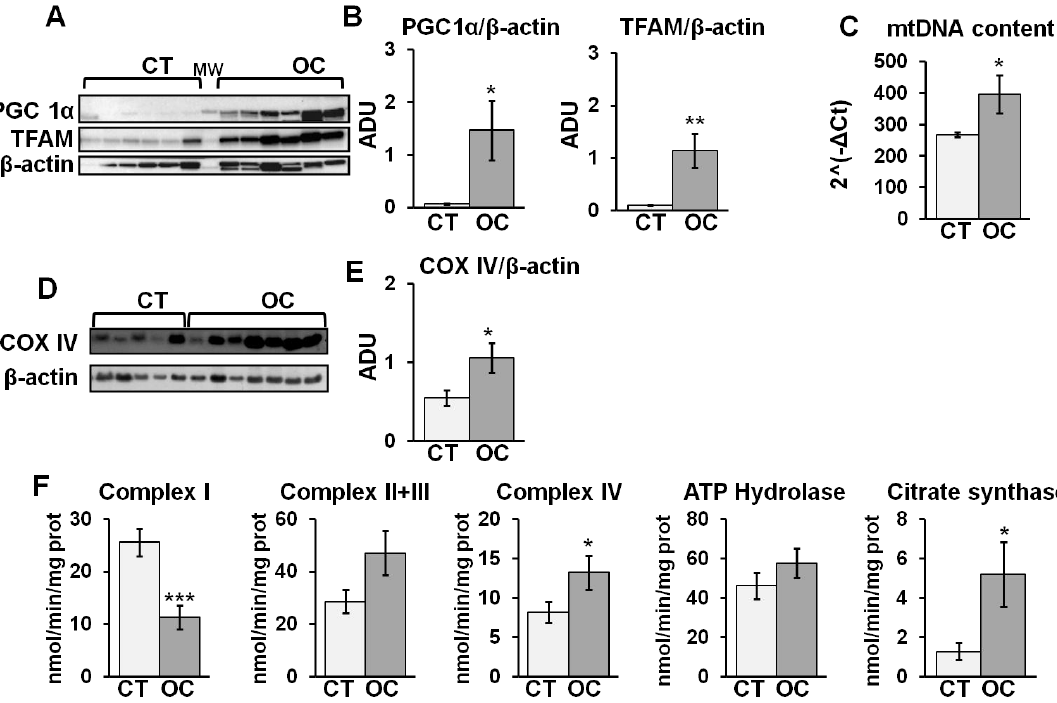
Figure 3. Mitochondrial biogenesis, oxidative phosphorylation system (OXPHOS), and citrate synthase activities in CT and OC tissues. The sample tissues of CT and OC were homogenized in buffer A and centrifuged at 600× g ; the resulting supernatant was sonicated and utilized for Western blotting analysis and enzymatic activities. ( A , D ) Representative images of Western blotting analysis. Proteins from CT and OC samples were loaded on 8% SDS-PAGE. After separation, the proteins were transferred to nitrocellulose membranes and immunoblotted with the antibodies against peroxisome proliferator-activated receptor-gamma coactivator-1alpha (PGC1α), mitochondrial transcription factor A (TFAM), and subunit IV of cytochrome c oxidase (COX IV). Protein loading was assessed with β-actin antibody. ( B , E ) The histograms represent the means of values of ADU ± SEM of samples. ( C ) Mitochondrial DNA (mtDNA) content was calculated as target ND1 gene and the reference β-actin gene. The histograms represent the average of the ratio ± SEM of values obtained from different samples. For mtDNA, 12 CT and 10 OC samples were analyzed. ( F ) The activities of OXPHOS complexes (complex I, II + III, IV, and ATP hydrolase) and citrate synthase were assayed spectrophotometrically. The histograms represent the means of values ± SEM of determinations in different samples (* p < 0.05, ** p < 0.01, *** p < 0.001, Student’s t -test). For other details, see Section 4.